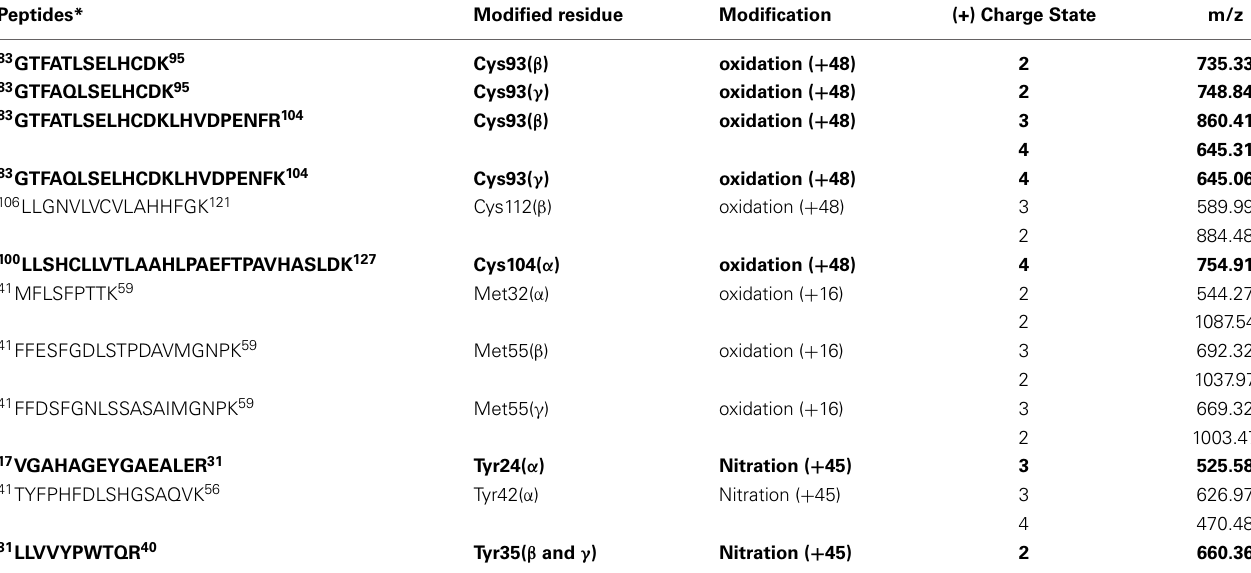
Table 1 | “Hotspot” modified amino acids identified in the reaction of hemoglobins with peroxide.